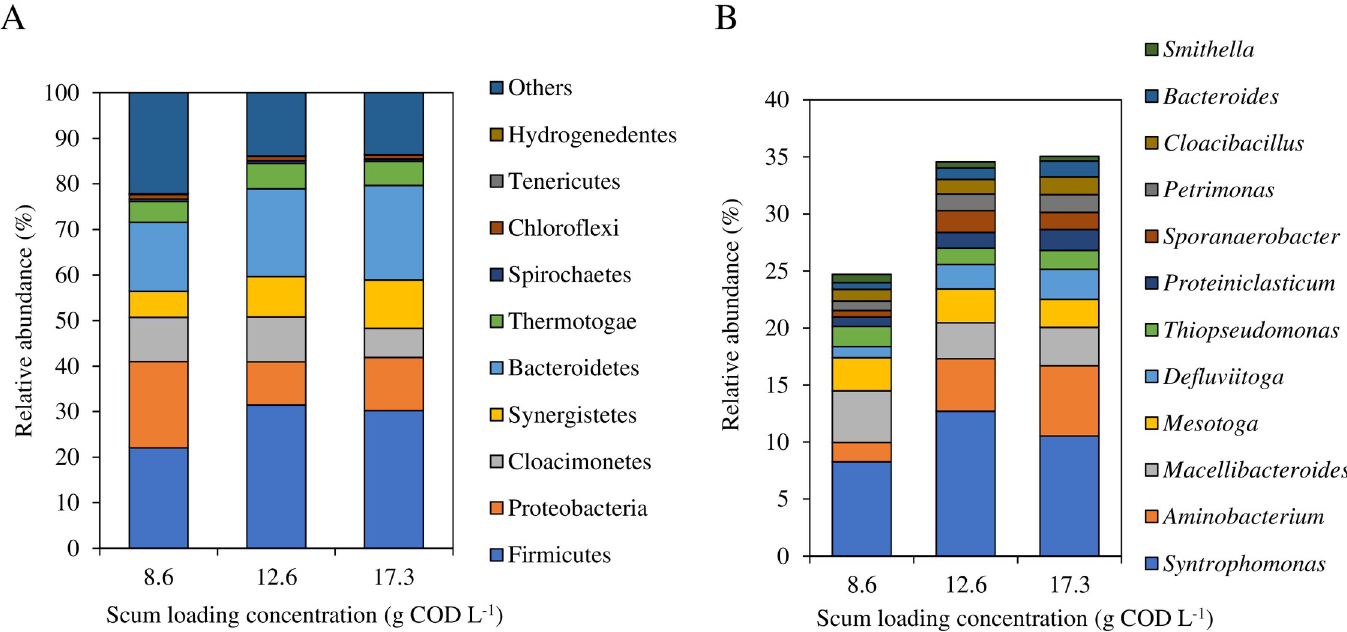
Fig 5. Relative abundance of bacterial groups based on 16S rRNA genes amplicon sequencing on day 8. The 10 most abundant phyla (A) and the 12 dominant genera (B) are shown.